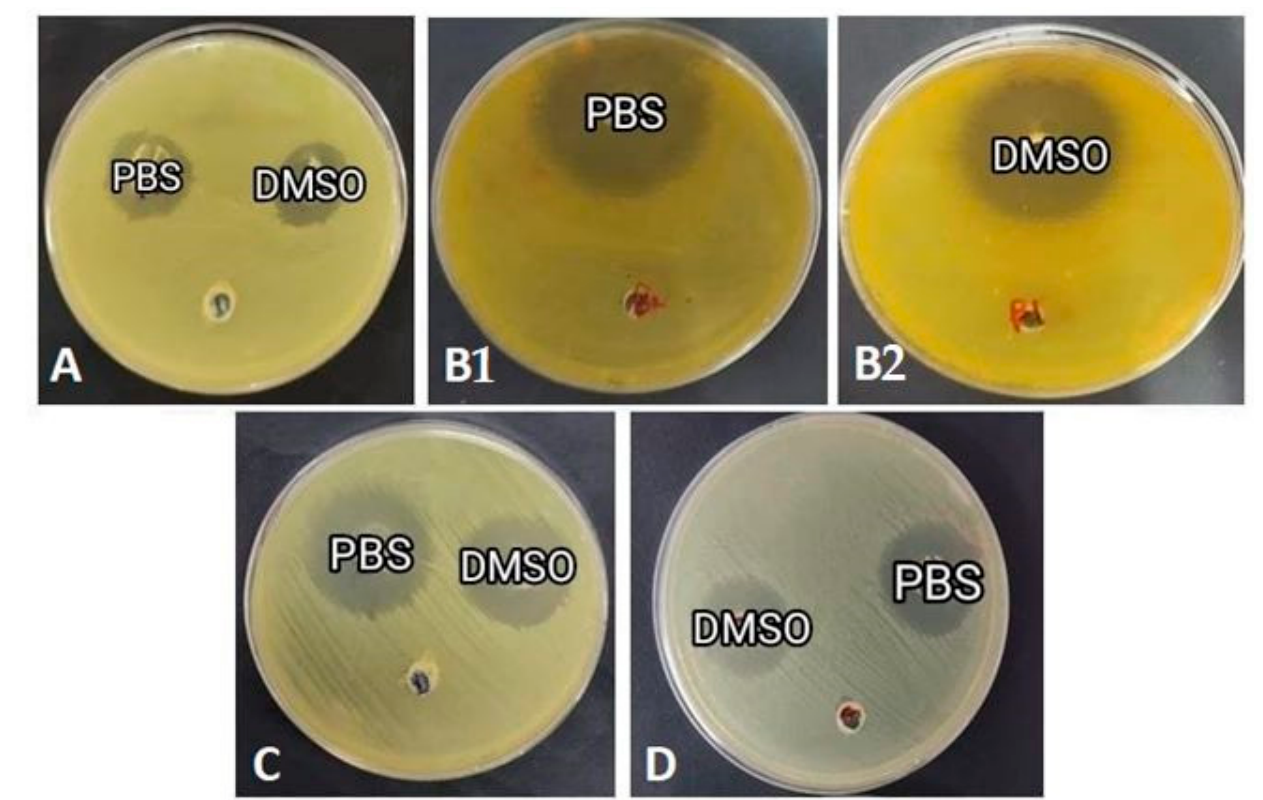
Figure 5. Antimicrobial activity of honey bee hemolymph extracted in PBS or DMSO against E. coli , where ( A ): bees from Port Said, ( B1 , B2 ): bees from Ismailia governorate, ( C ): bees from Suez gover- norate, ( D ): bees from Saint Catherine.